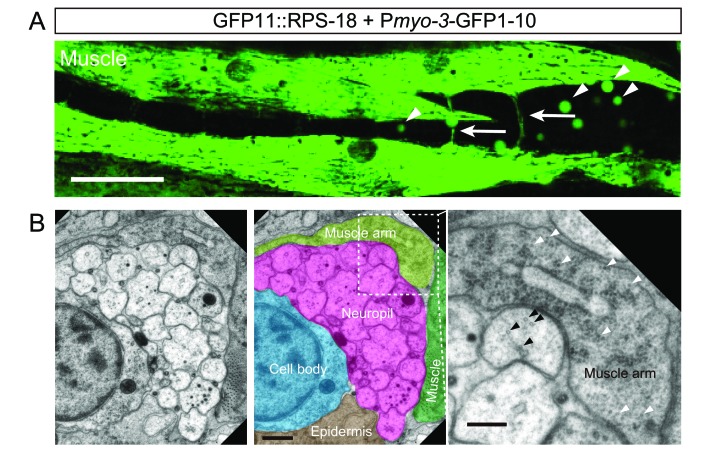
RIBOS visualizes ribosomes in muscle arms.(A) Ribosome distribution in muscles visualized by Pmyo-3-RIBOS (juSi94[GFP11::rps-18]; rps-18(0); juEx5377[Pmyo-3-GFP1-10]). Ventral nerve cord runs horizontally in the middle of the image. Ribosomes in muscle arms are shown by arrows. Arrowheads indicate autofluorescence in the intestine. Scale bar: 20 µm. (B) Electron micrographs of the ventral nerve cord and muscle arm. Right panel is the enlarged muscle arm (dotted square in the middle panel), filled with ribosomes detected as 20 nm electron-dense structures (white arrowheads). Black arrowheads indicate microtubules in neurons, which have a similar diameter to ribosomes. Scale bar: 400 nm; 200 nm in the magnified image.